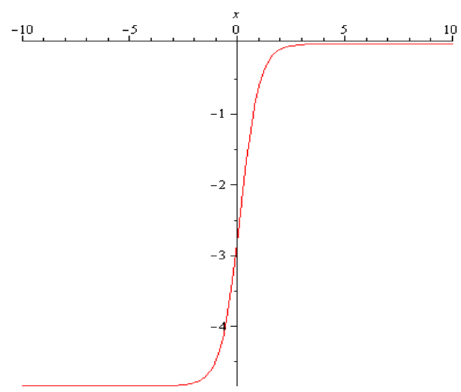
Figure 1. The solitary wave 3D graphics of Equation (24) shows a kink shaped soliton profile for, within the interval .